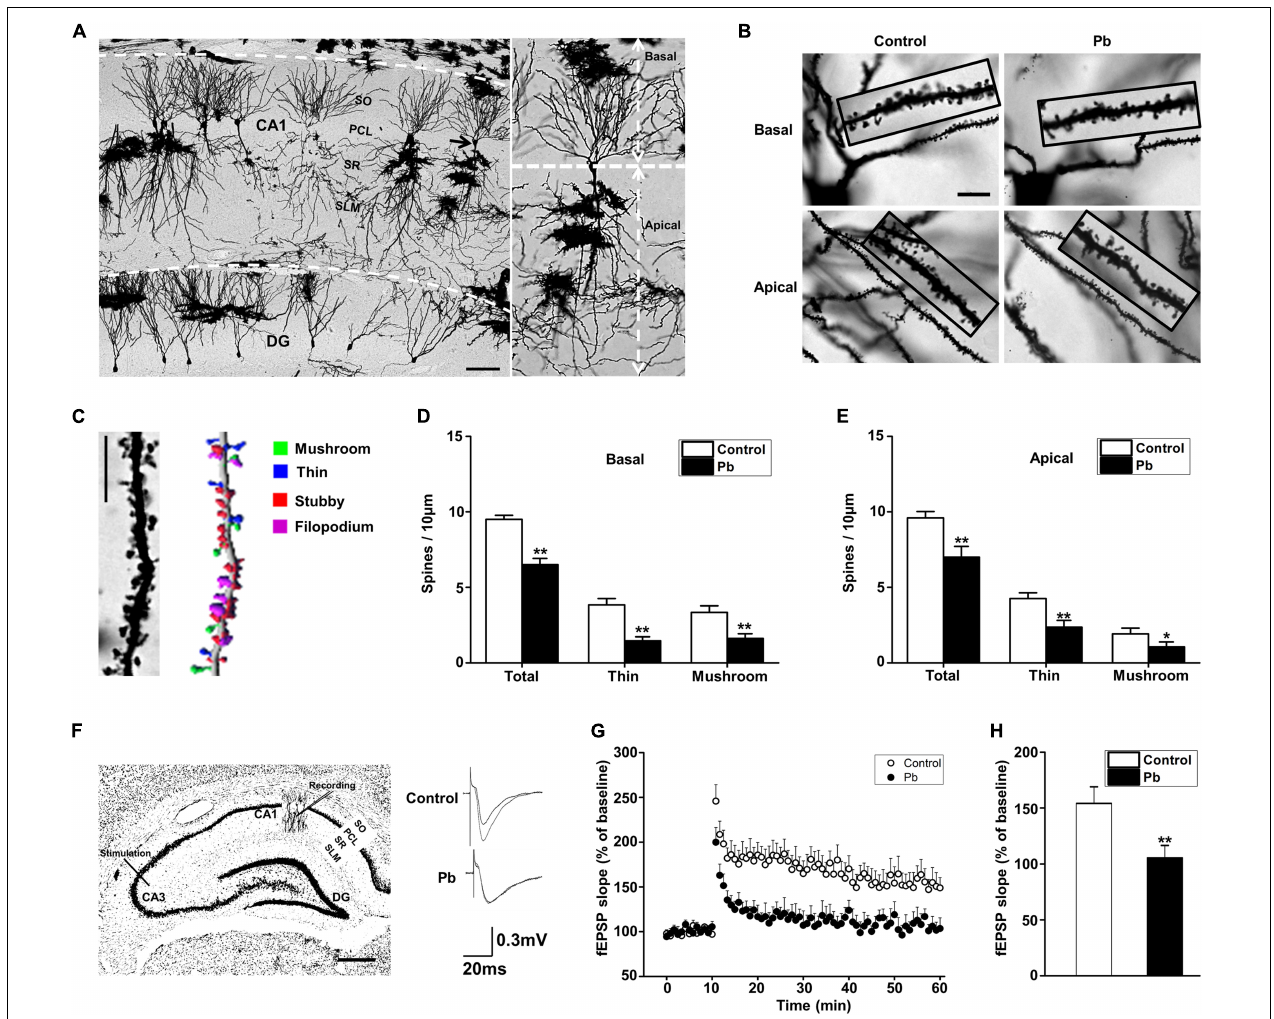
FIGURE 2 | Hippocampal Pb accumulation and impairment of synaptic plasticity in PND30 rats. (A,B) Golgi Staining for basal and apical dendritic spines in hippocampal CA1 region. Scale bars = 100 µ m in (A) and 10 µ m in (B) . (C) Imaris reconstruction of the dendritic spines of pyramidal neurons in CA1 region. Scale bar = 10 µ m. (D,E) Statistical analysis of the effect of Pb exposure on basal and apical spines. For each group, data are expressed as mean ± SE of spines per 10 µ m (16 neurons/8 rats for all groups), * p < 0.05, ** p < 0.01. (F) LTP induced by high-frequency tetanic stimulation. Simulations were applied to the CA3 regions of the hippocampus and the signal was collected at the CA1 region. Scale bar = 500 µ m. (G,H) LTP in hippocampal regions CA3-CA1. Abscissa represented the time of tetanic stimulation. N = 16 slices per 8 rats in each group. The patch-clamp recordings showed that the fEPSP slope for rat hippocampal LTP in the Pb-exposed group was significantly reduced compared with that in the control group. Data are expressed as mean ± SE, ** p < 0.01. SO, stratum oriens; PCL, pyramidal cell layer; SR, stratum radiatum; SL-M, stratum lacunosum-moleculare; DG, dentate